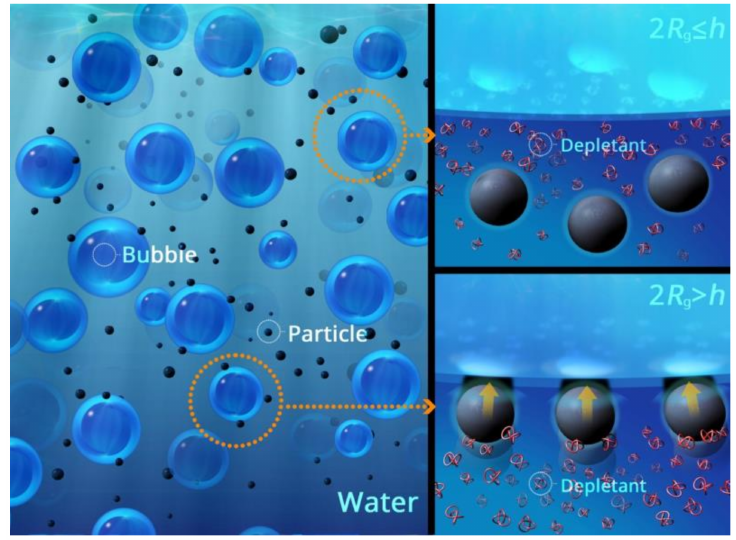
Figure 1. Schematic of the depletion interaction in a typical flotation process. The depletion agent does not influence the particle-bubble interaction when their separation distance ( h ) is larger than the diameter of the depletion agent (2 R g ), that is, h ≥ 2 R g . However, the attractive force due to depletion begins to be exerted when the particles come closer to the bubble than the diameter of the depletion agent ( h < 2 R g